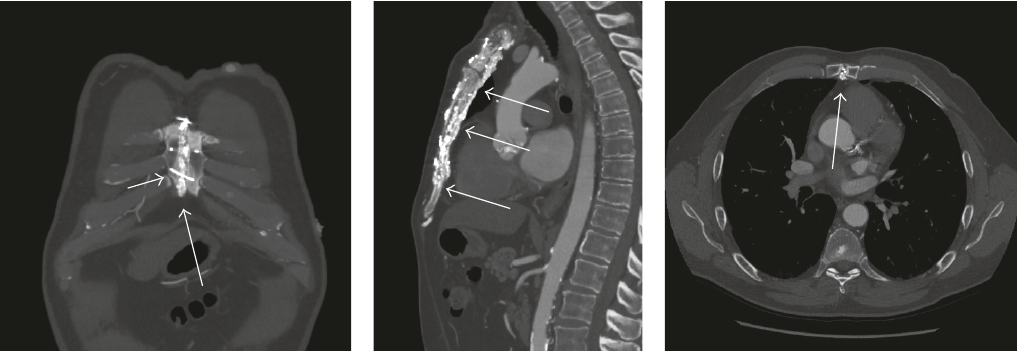
Figure 1: CT angiography 6 years post-CABG demonstrating sternal closure with wire cerclage (short arrow) and Kryptonite bone cement (long arrows).